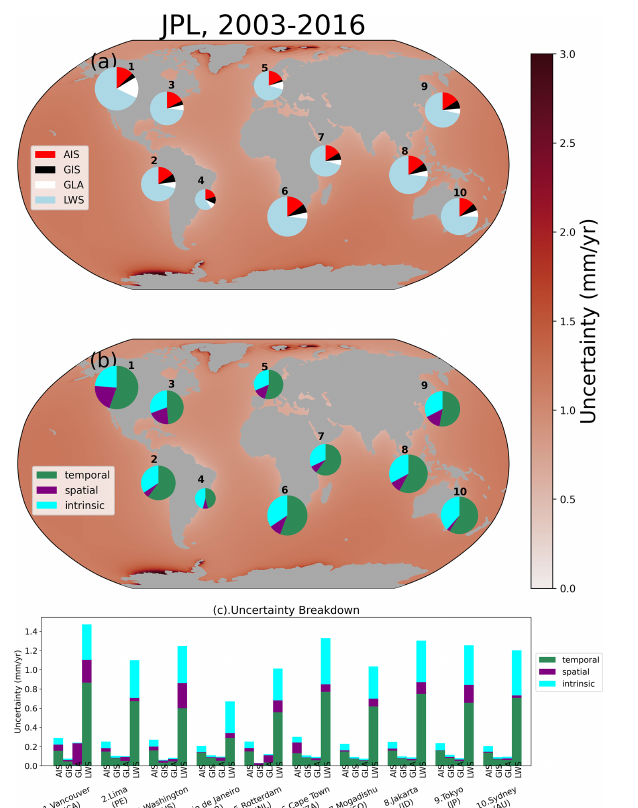
Figure B7. Same as Fig. 8, but without the contribution of land water storage